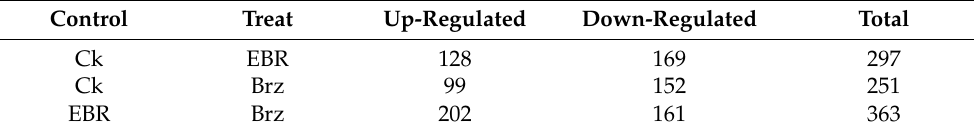
Table 2. Number of DEGs detected in comparison with other experiments.